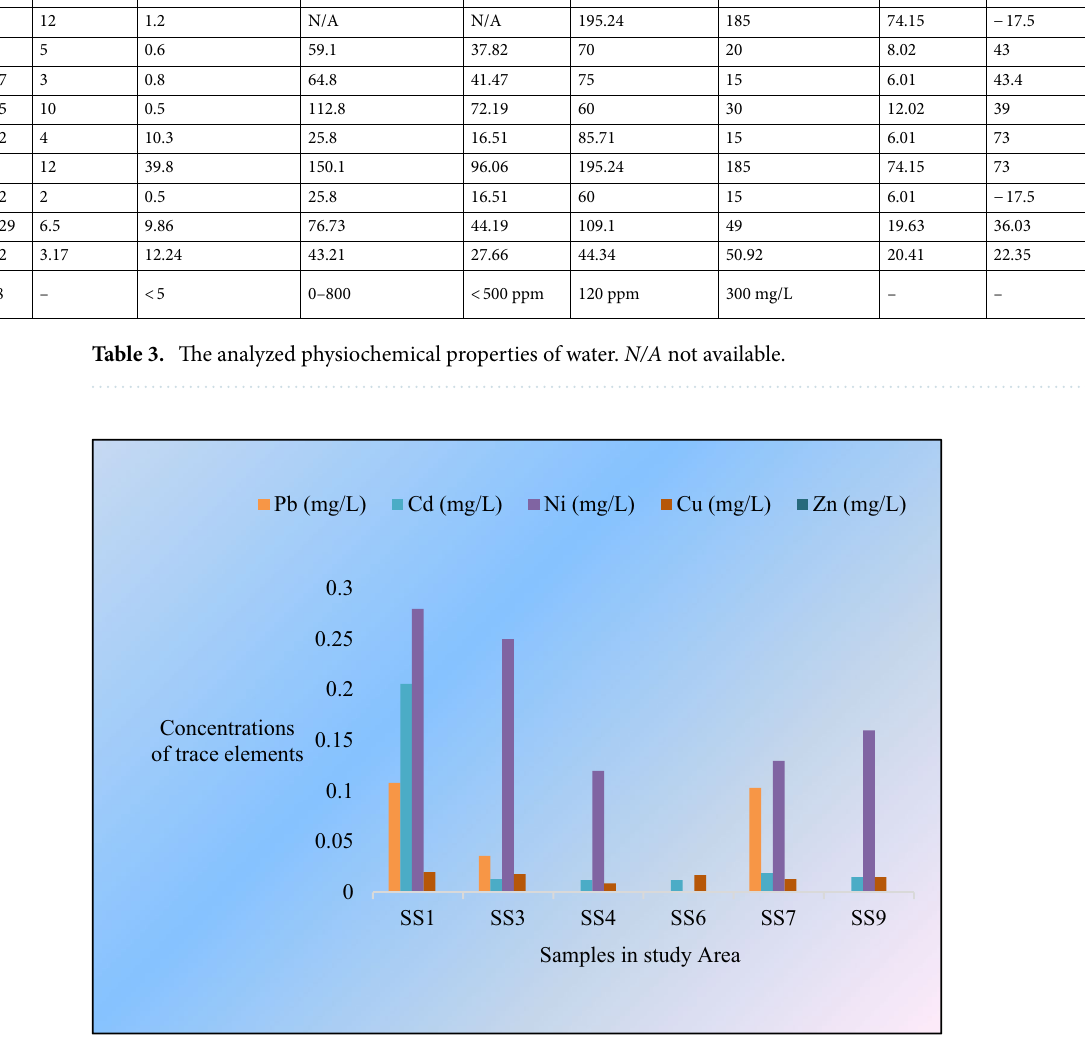
Figure 3. The concentration of trace elements in the study